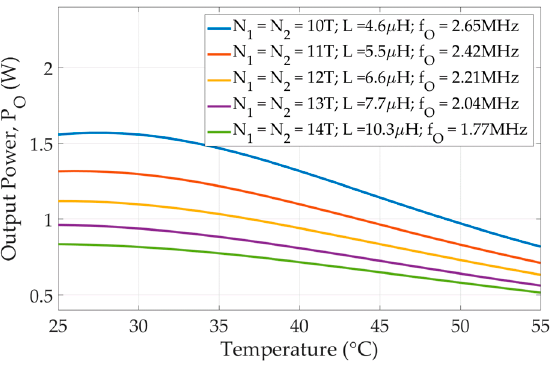
Figure 8. The variation in the output power for increasing the number of turns for the coupling coils.